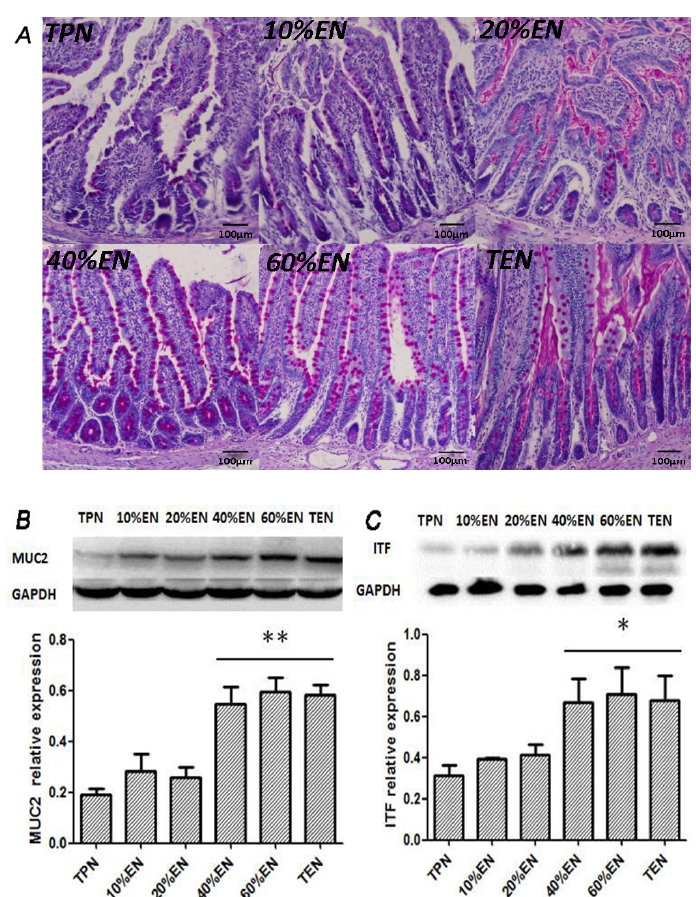
Figure 5. Goblet cell function analysis of in the distal ileum epithelium. ( A ) Periodic acid schiff (PAS) staining (purple red) of goblet cells (×200). The counts of goblet cells had no significant difference between groups (all the p < 0.05). However, there was an observable mucus secretion activity of cells in 40% and more EN groups; ( B ) Western blotting analysis of MUC2; ( C ) Western blotting analysis of ITF. MUC2 was significantly increased in 40%, 60%, and TEN groups compared with TPN ( p = 0.006, 0.007, and 0.007, respectively). Parallel expression of ITF was also found among 40%, 60%, and TEN groups ( p = 0.033, 0.042, and 0.029 compared with TPN). * p < 0.05, compared with TPN group; ** p < 0.01, compared with TPN group.